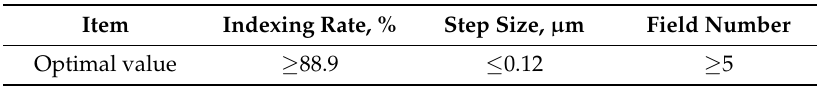
Table 3. The optimal parameters for analyzing retained austenite in TRIP590 steel (reproduced from [18], with permission from Springer,